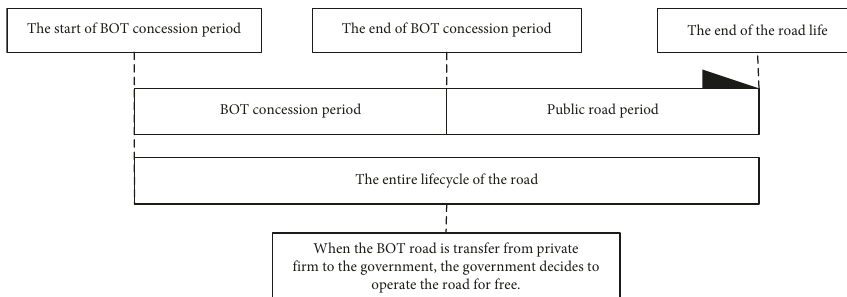
Figure 1: A BOT road becomes a public road.